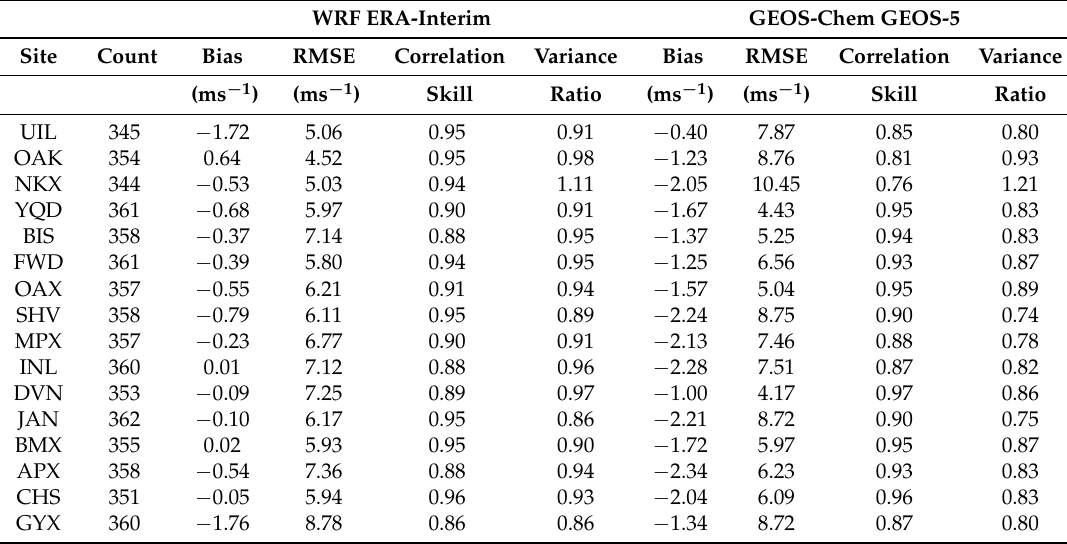
Table A3. Model comparison to rawinsonde wind speed at mandatory reporting level 250 hPa, 00 UTC in